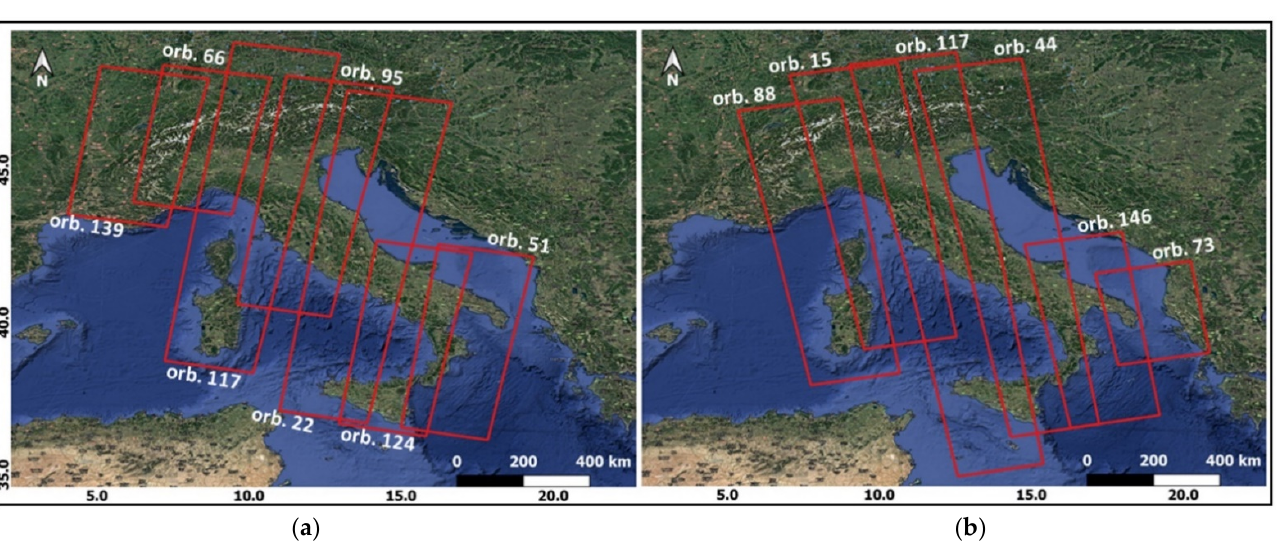
Figure 1. Portions of the Sentinel-1 orbits covering the Italian territory. Panel ( a ): descending orbits (morning overpasses); panel ( b ): ascending orbits (afternoon overpasses).